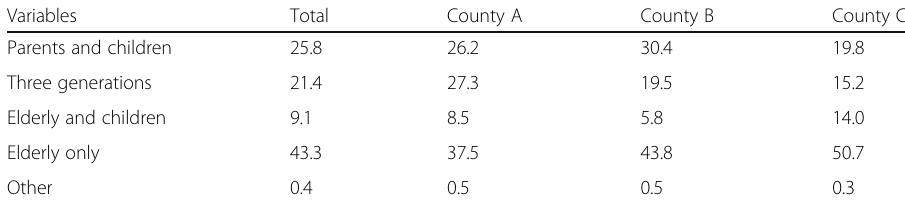
Table 9 Household structures in sample counties (%) Variables Total County A County B County C Parents and children 25.8 26.2 30.4 19.8 Three generations 21.4 27.3 19.5 15.2 Elderly and children 9.1 8.5 5.8 14.0 Elderly only 43.3 50.7 Other 0.4 0.5 0.5